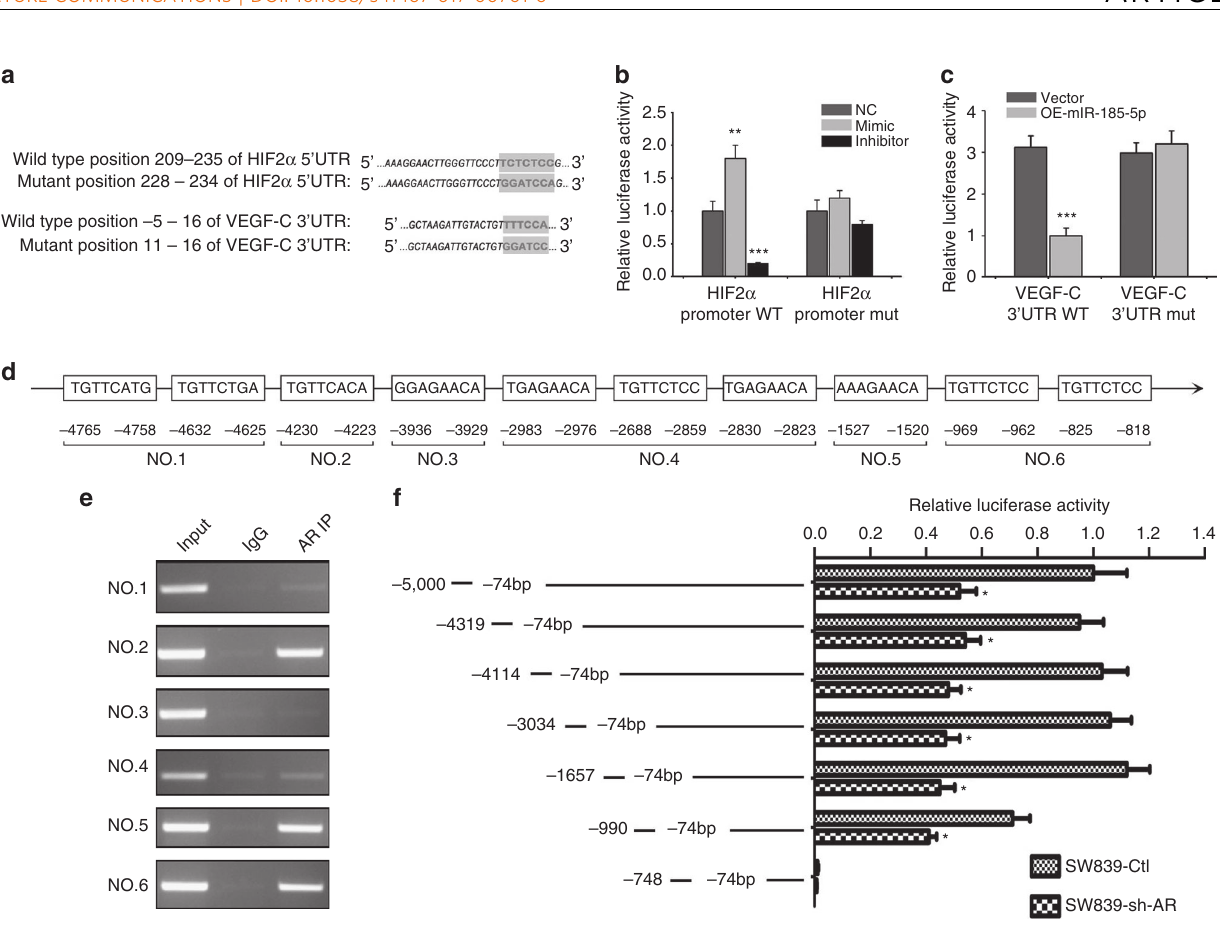
Fig. 6 AR regulates expression of miR-185-5p that targets HIF2 α and VEGF-C. a Mutations introduced at the target sequence of miR-185-5p in HIF2 α and 3 ′ UTR of VEGF-C. b , c Luciferase reporter assays showing miR-185-5p can target HIF2 α promoter ( b ) and VEGF-C 3 ′ UTR ( c ) in SW839 cells. d Bioinformatics analysis of potential AR binding sites on the miR-185-5p promoter using online software ALGGEN PROMO. e ChIp assay showing AR can bind to several potential binding sites on the miR-185-5p promoter. f Promoter truncation showing that AR binding to region between − 1527 to − 1520 and − 969 to − 818 bases of miR-185-5p promoter is important for AR ’ s regulation of miR-185-5p. Activity of 5K promoter ( − 5000 to − 74) in SW839-control was used as a control. All experiments were carried out in triplicate. * p < 0.05, *** p < 0.001 were considered statistically signi fi cant by t -test for two groups or ANOVA for more than two